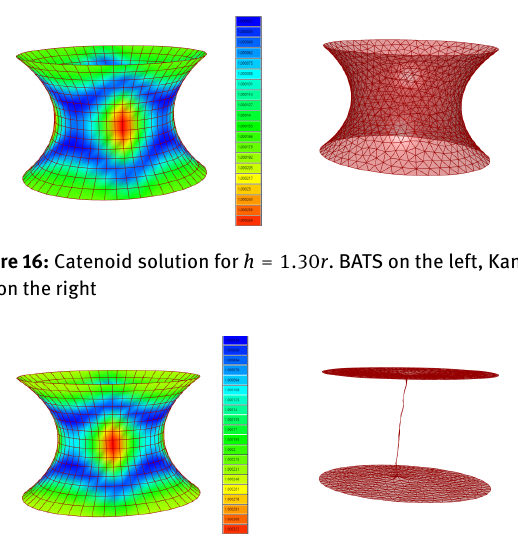
Figure 17: σ 1 plot of the catenoid solution for h = 1.32 r . BATS on the left, Kangaroo on the right